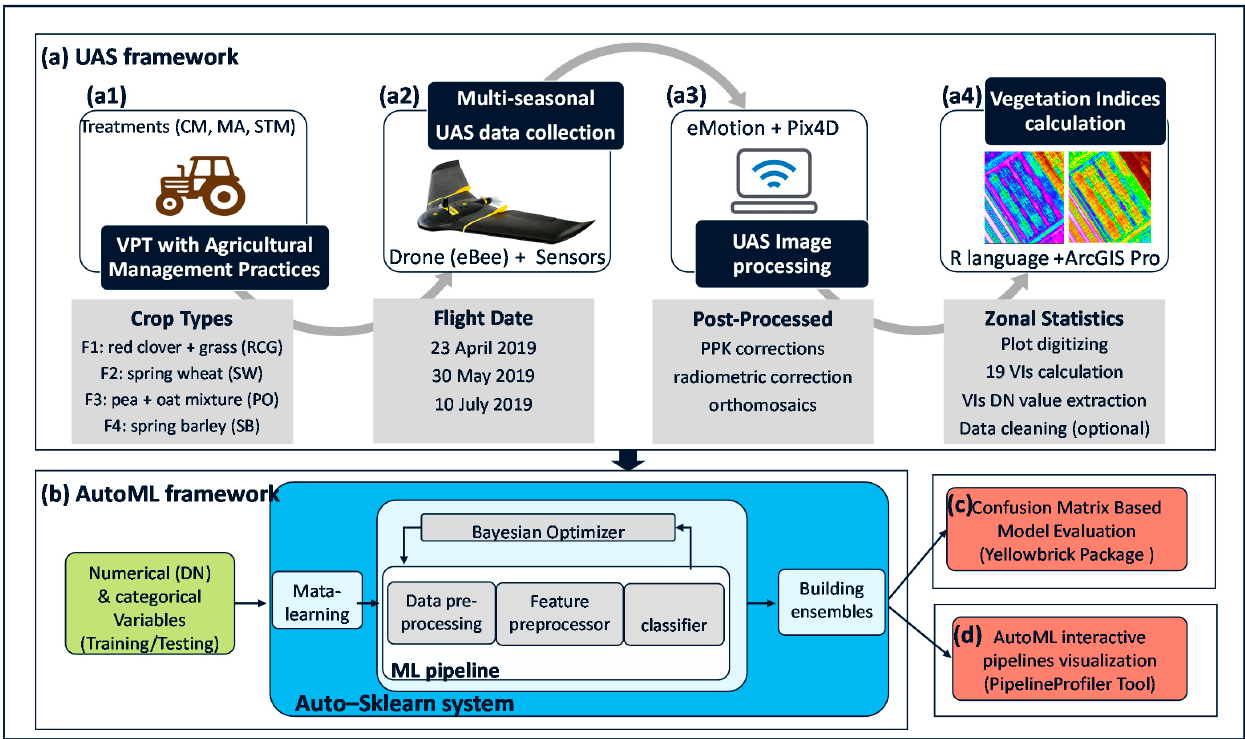
Figure 2. The flowchart of the UAS and AutoML framework in this study. ( a ) The UAS framework, where ( a1 ) Three types of AMPs were processed for four crop categories. ( a2 ) The eBee plus with Parrot Sequoia multispectral sensor with the time series flight (April, May, and July) to collect spectral information from different crop periods. ( a3 ) UAS image post-processed in SenseFly eMotion with PPK corrections and orthomosaics in Pix4D. ( a4 ) 19 VIs calculation, segmentation and corresponding plot digital number (DN) extraction for AutoML modeling. ( b ) The Auto-sklearn framework constructed ML pipelines automatically, which were proposed by the Bayesian optimization method with warm-started meta-learning and joint with post hoc ensemble building approach to achieve robust performance (adapted from [30,40]). ( c ) Yellowbrick visualization package was conducted for AutoML model evaluation. ( d ) PipelineProfiler was conducted for AutoML interactive pipelines visualization tool allows the examination of the solution space of end-to-end ML pipelines.